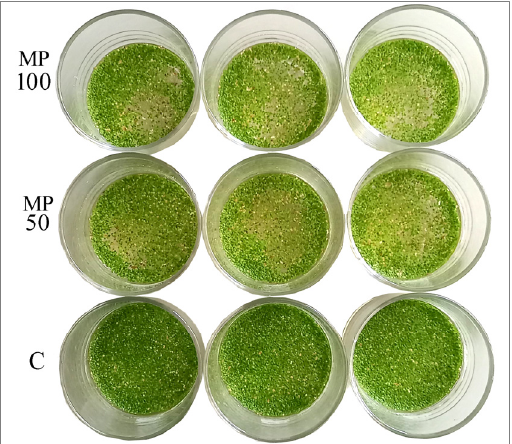
Figure 3. Biomass of L. minuta in the control (C) and microplastic treatments (MP50 and MP100) at T28. For each group, the three replications are shown.